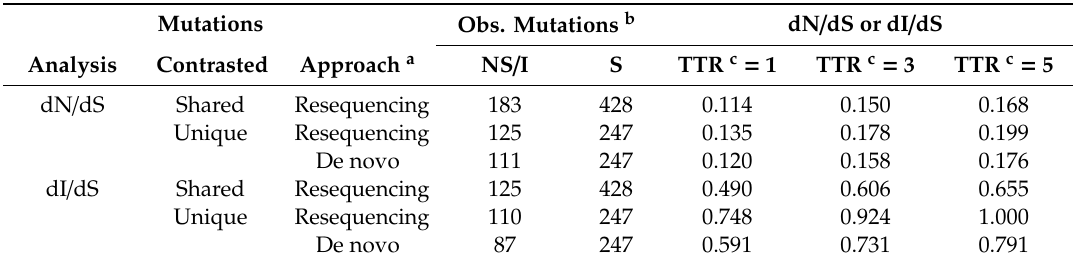
Table 2. dN / dS and dI / dS analysis for whole